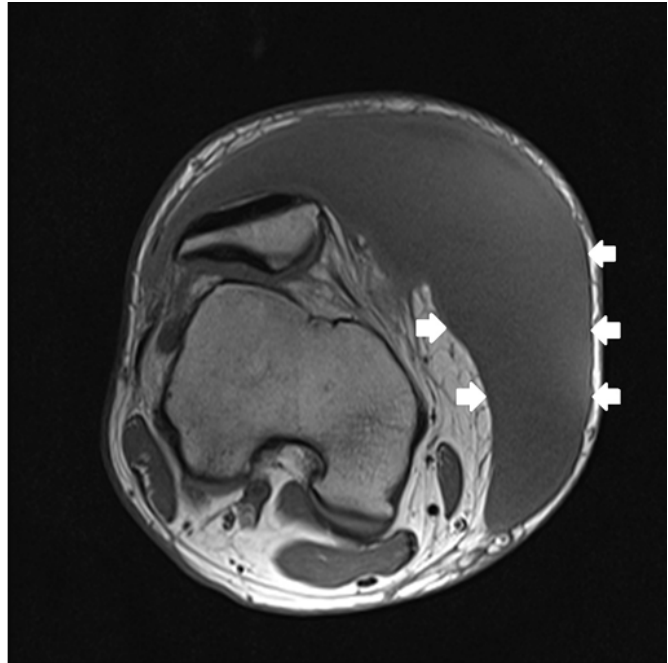
Figure 2d. Axial T1-weighted magnetic resonance imaging shows enhancement of the